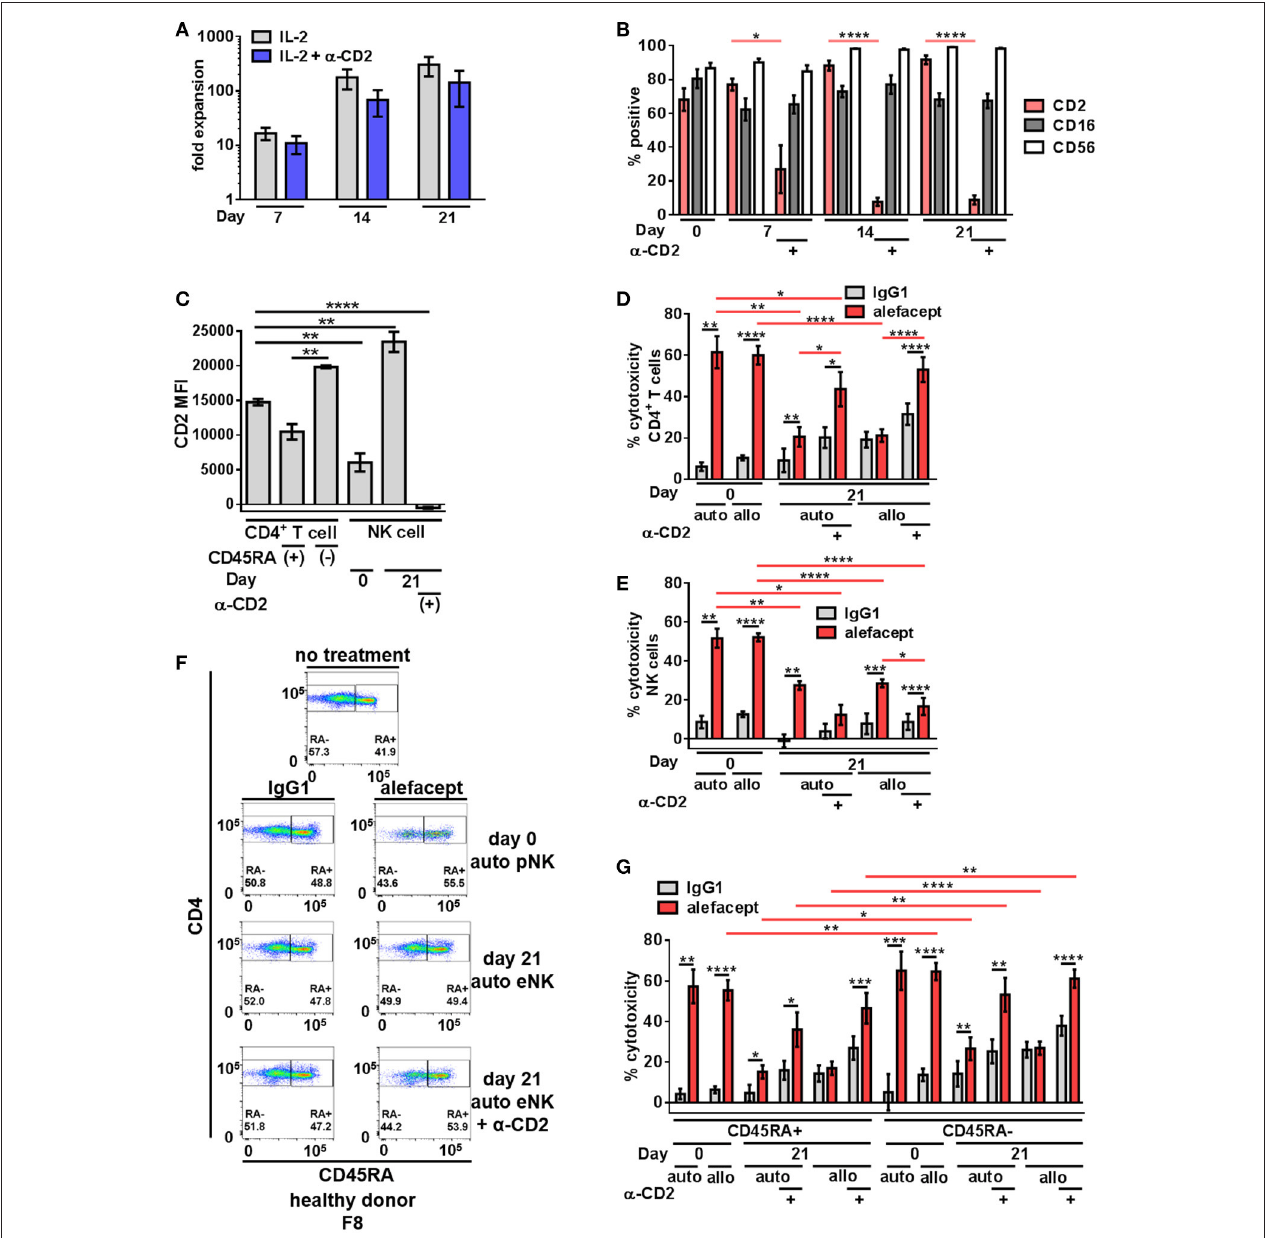
FIGURE 2 | Expanded NK cells exhibit enhanced spontaneous killing and reduced ADCC compared to primary NK cells; ADCC can be rescued by engaging CD2. (A) Primary NK cells from healthy donors were expanded on K562 C9 feeder cells with membrane bound IL-21 with recombinant human IL-2 ± BD FastImmune TM α -CD2. (B) Percent positive of total population surface markers CD2, CD16, and CD56 throughout NK cell expansion as measured by flow cytometry. Statistical significance between CD2 across conditions are indicated in red. (C) CD2 MFI of cell types in killing assay where primary NK cells (day 0) or expanded NK cells (day 21) are co-cultured with CD4 + T cells from the same donor (self;auto) or mismatched donor (non-self;allo) for 19h with E:T = 1:1 and 10 µ g/mL alefacept or IgG1 control antibody. (D) Percent cytotoxicity of self (auto) or non-self (allo) CD4 + T cells after co-culture with primary NK cells (day 0) or expanded NK cells (day 21) as measured by absolute count flow cytometry (E) Percent cytotoxicity of self (auto) or non-self (allo) NK cells (NK cell death) after co-culture with CD4 + T cells as measured by absolute count flow cytometry (F) Representative flow cytometry plots of healthy donor day 0 primary NK cells or day 21 expanded NK cells killing self (auto) CD4 + T cells with CD4 vs. CD45RA. (G) Percent cytotoxicity of CD4 + T cell subsets CD45RA + and CD45RA– of bulk CD4 + T cell population shown in (D) . Mean and SEM shown for 4 healthy donors, * P ≤ 0.05, ** P ≤ 0.01, *** P ≤ 0.001, **** P ≤ 0.0001. For percent cytotoxicity graphs, statistical significance between IgG1 and alefacept conditions are indicated with black bars and statistical significance between cell types with alefacept are indicated with red bars.